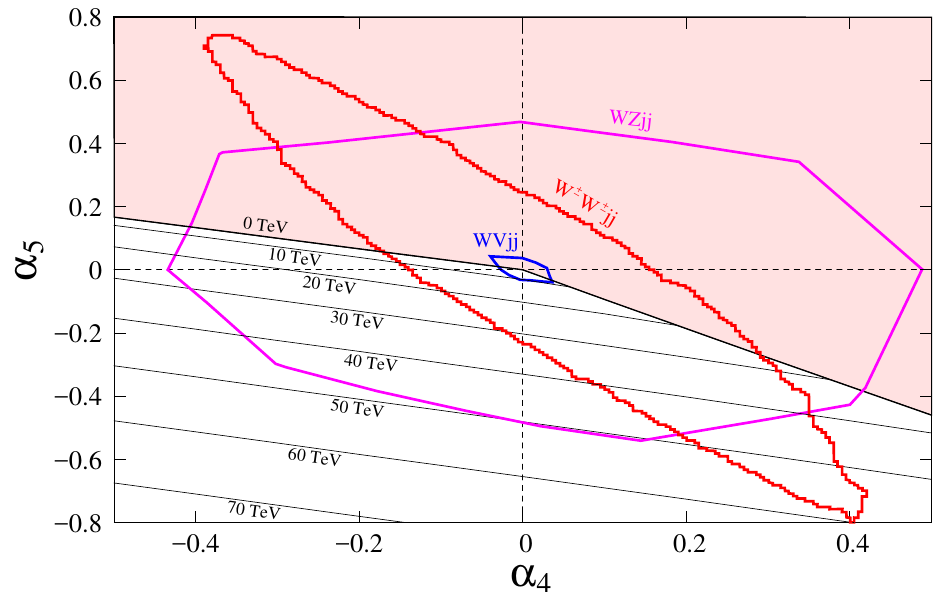
Figure 3 . Mass of the EW-Skyrmion on the (cid:11) 4 { (cid:11) 5 plane. Contours for the mass of 10 TeV, 20 TeV, (cid:1) (cid:1) (cid:1) 70 TeV are shown as black solid lines. In the shaded regions, there is no solution which satis(cid:12)es required equations and boundary conditions. 95% CL allowed region (inside of contours) from several experiments (refs. [8{10]), indicated by W (cid:6) W (cid:6) jj , WZjj , and WV jj , are also shown. (See the main text for detailed